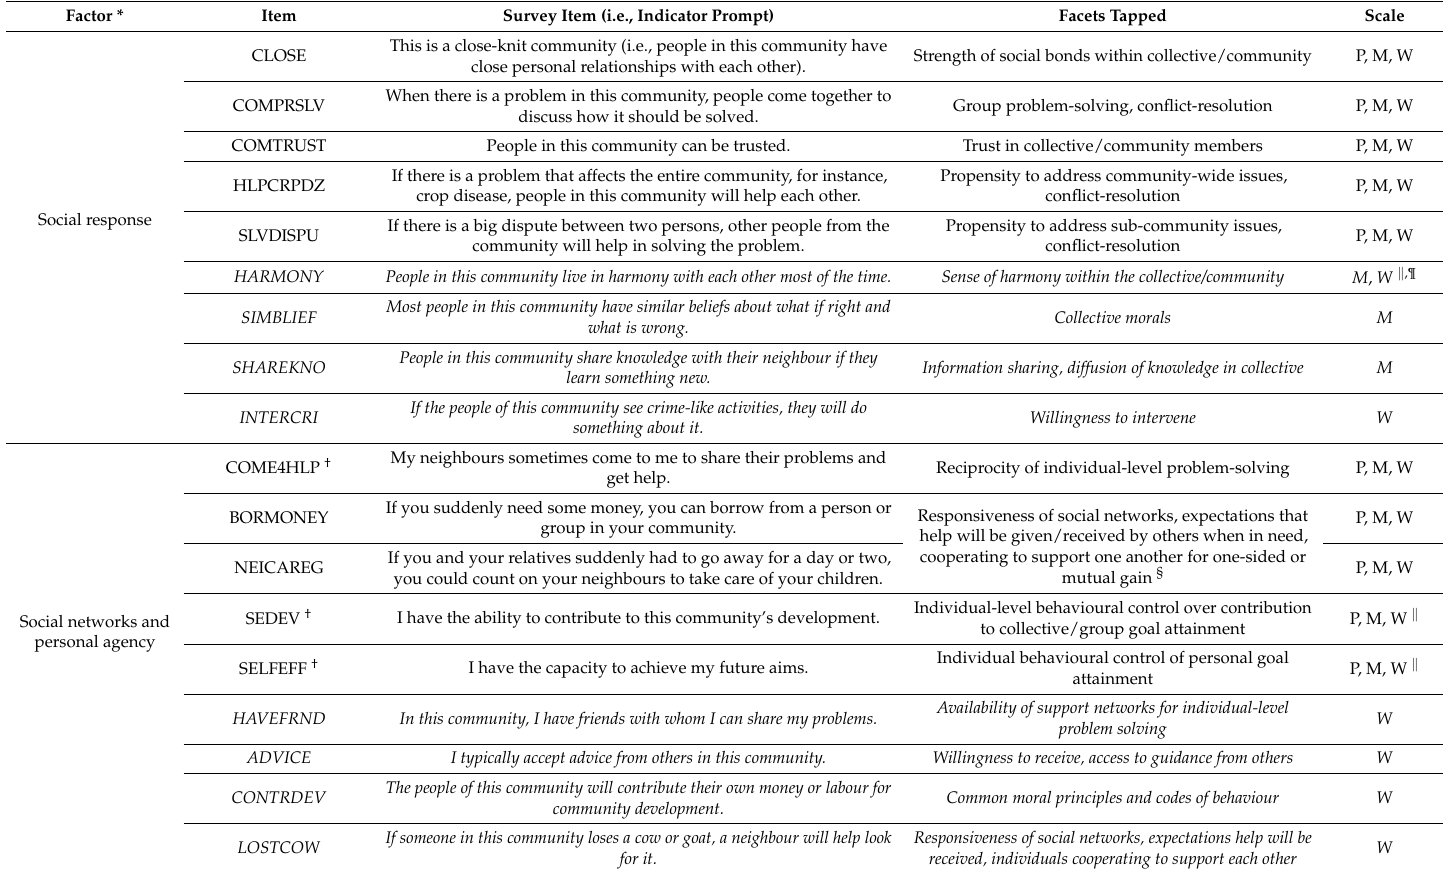
Table 5. Final collective efficacy scales, and comparison of single-group (men vs. women) CE factors structures. Factor